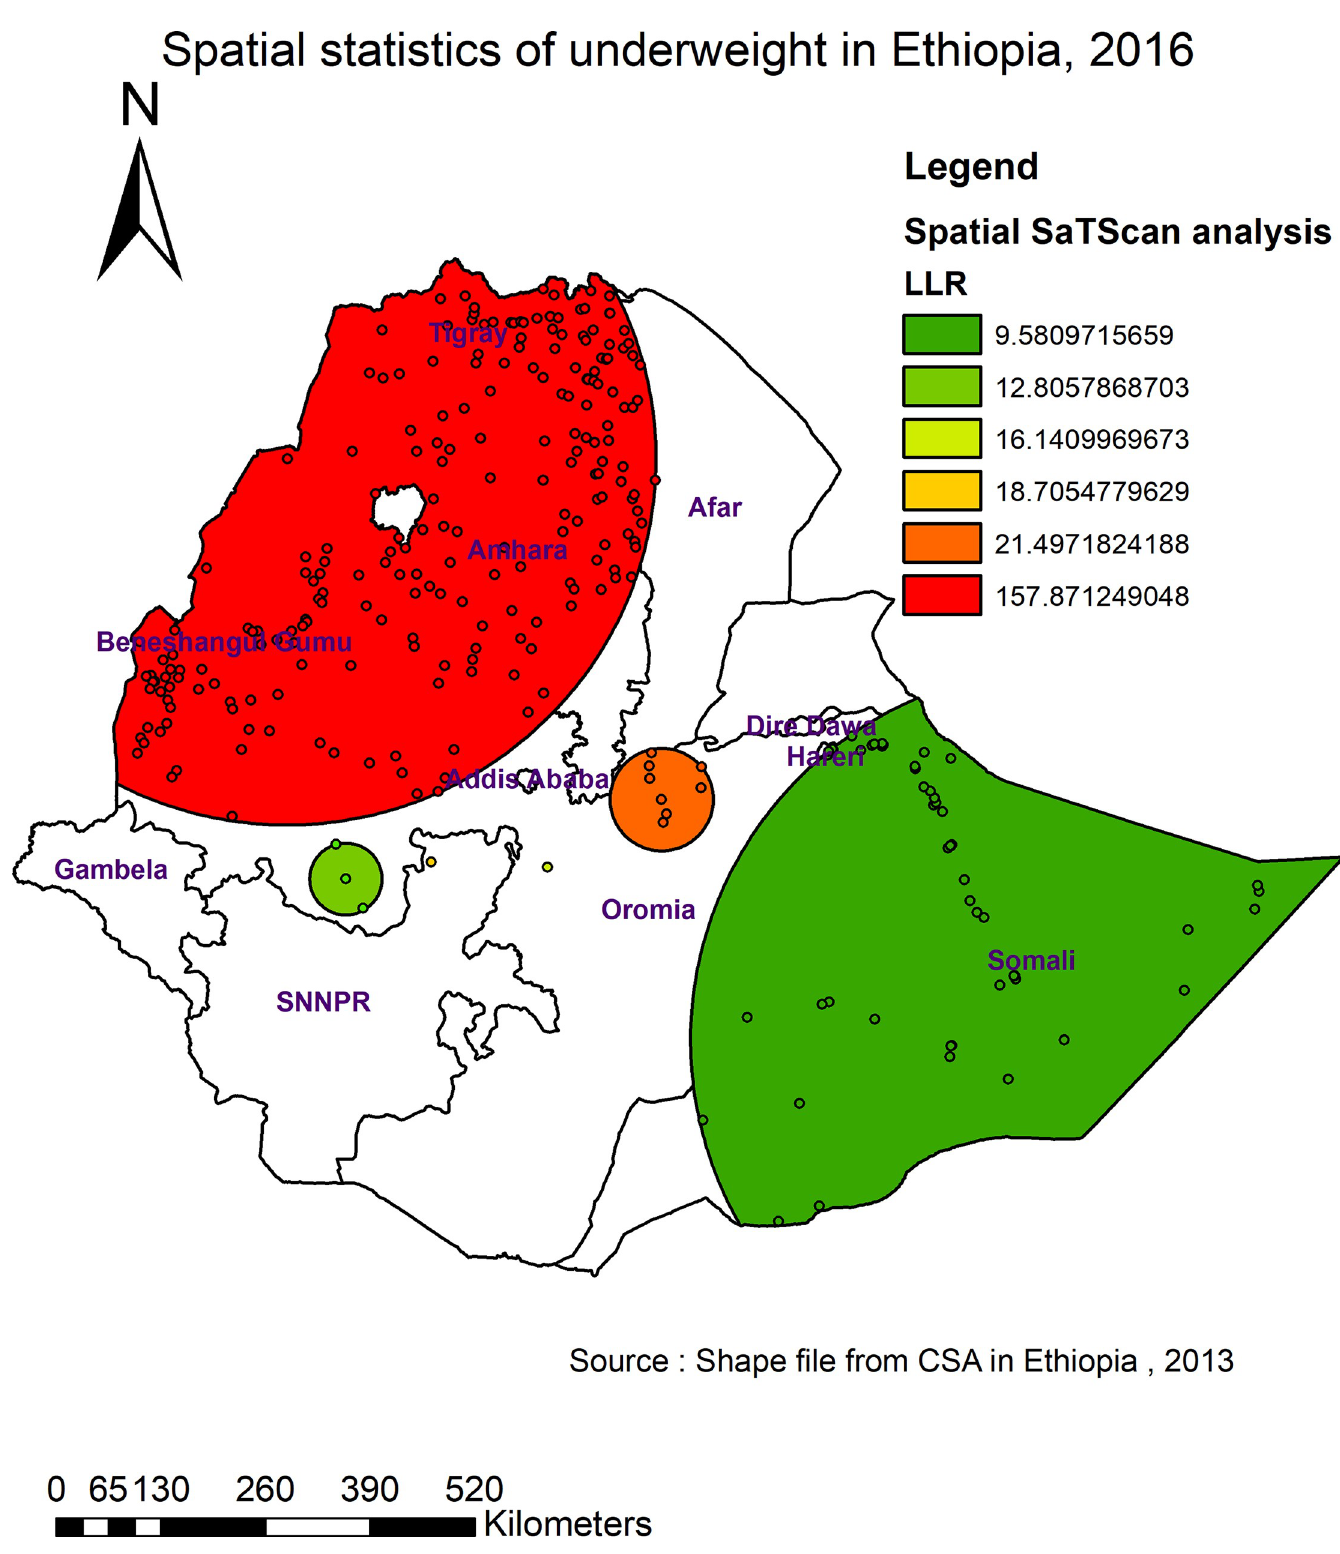
Fig 4. Primary and secondary clusters of underweight among individuals age 15–49 years in Ethiopia, 2016.